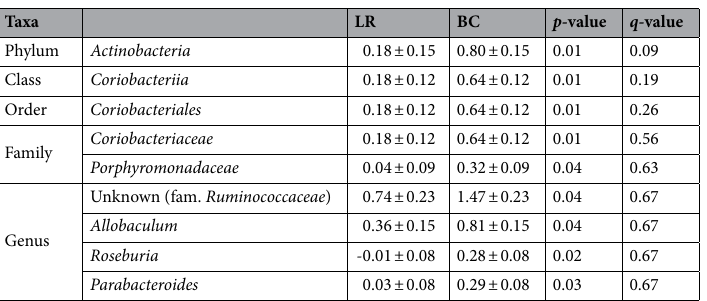
Table 3. Faecal microbiome populations of Labrador Retrievers (LR, n = 15) and Border Collies (BC, n = 14) which differed significantly. Data (% of sequences) are given as LSmeans ±